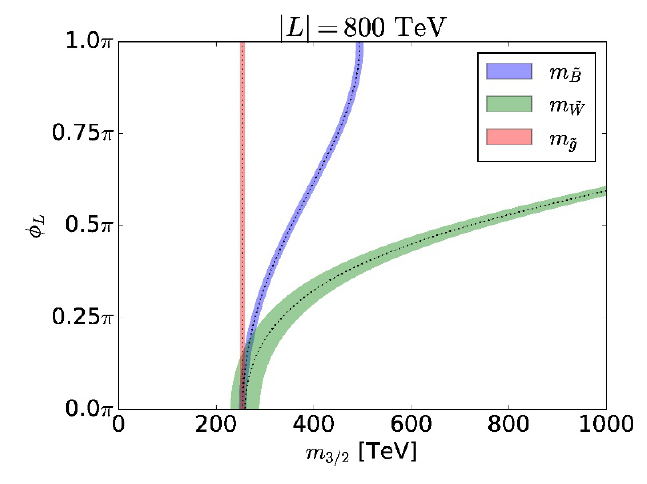
Figure 15 . Contours of constant gaugino masses on the m The dotted lines show the true gaugino masses for Sample Point 1, while the bands show expected uncertainties due to the uncertainty in the gaugino mass